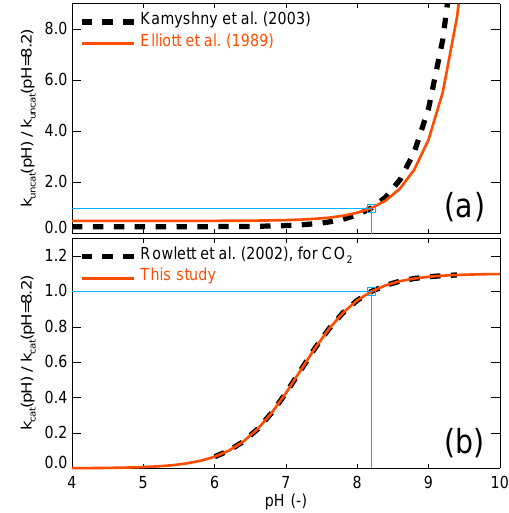
Figure 2. Response of the normalised (a) uncatalysed and (b) CA- catalysed OCS hydrolysis rates to changes in soil pH. Red lines indicate the parameterisation used for this study. The blue lines in- dicate the normalisation at pH =